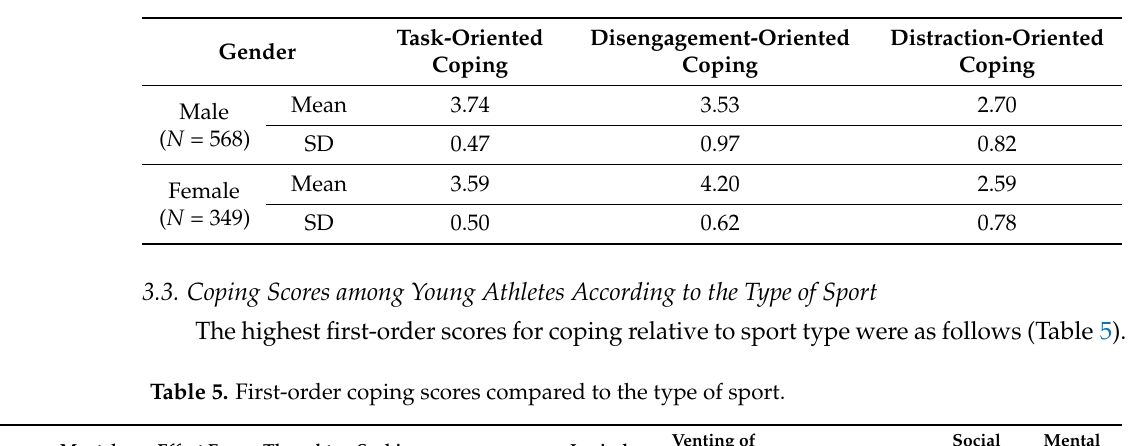
Table 4. Second-order coping scores relative to gender.